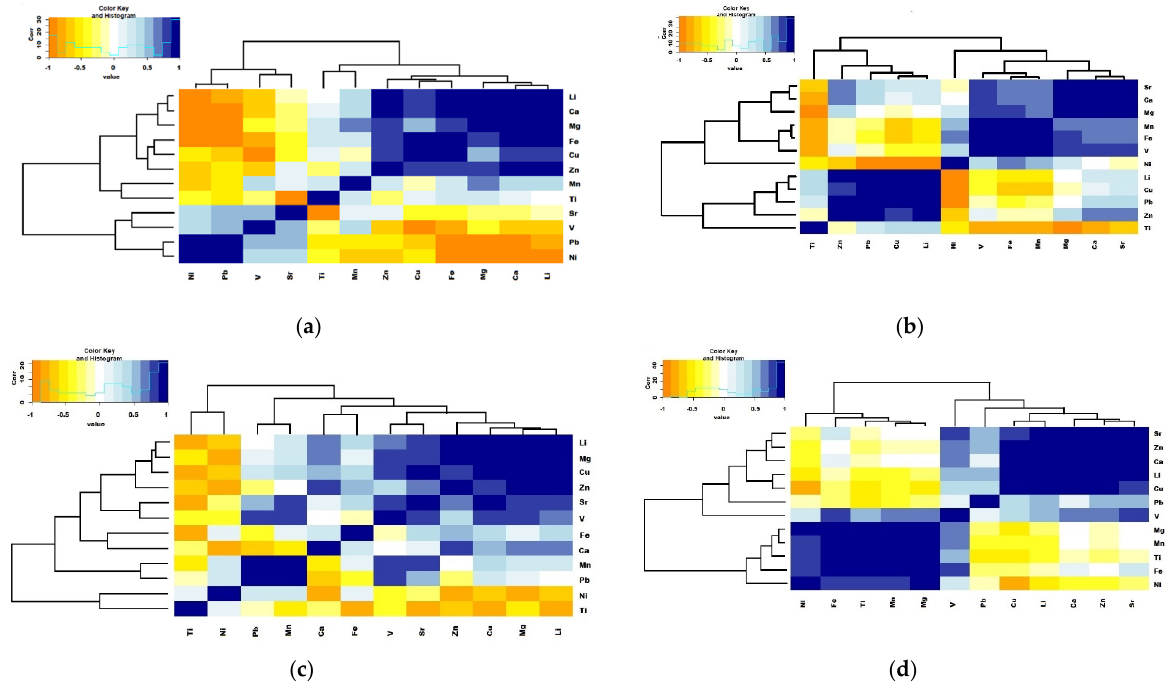
Figure 4. Fractionation of metal: ( a ) bioavailable fraction (F1); ( b ) reduced fraction (F2); ( c ) oxidized fraction (F3); and ( d ) residual fraction (F4).